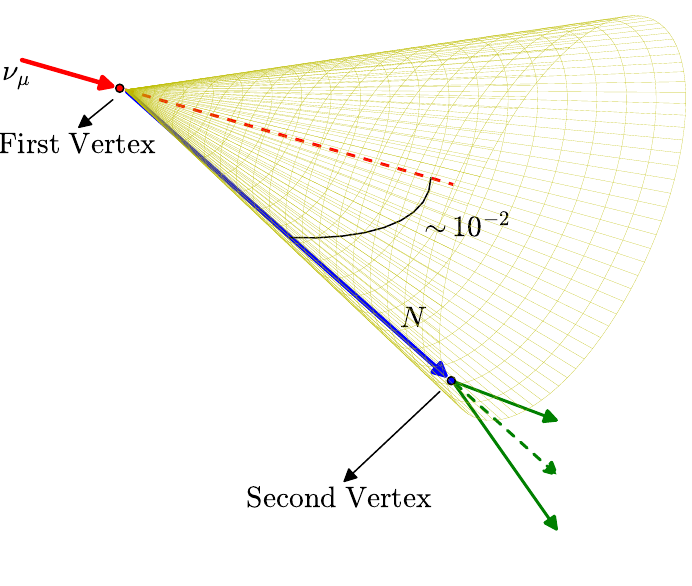
Figure 4 . Schematic topology of the signal event. The green arrows show the final particles from the N decay. The solid green arrows show jets. The dashed green arrow denotes